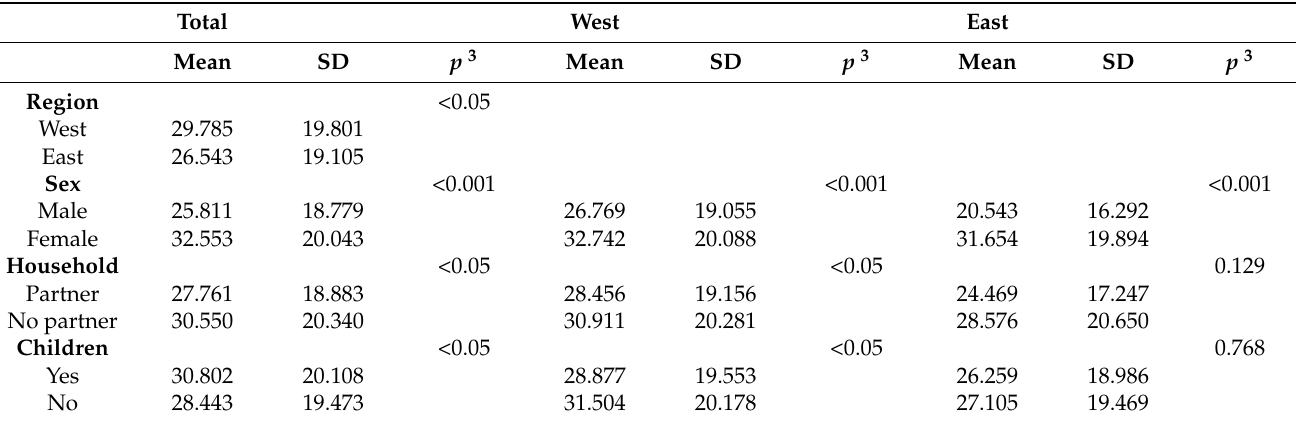
Table 3. Means of the exhaustion factor scores per